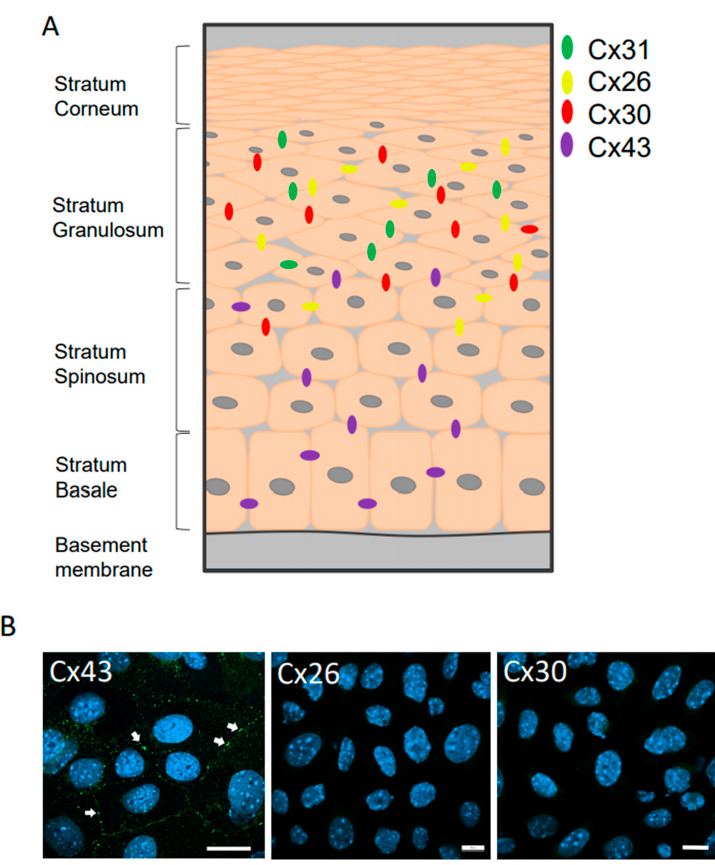
Figure 1. ( A ) Schematic model denoting the approximate location of Cx26, Cx30, Cx31 and Cx43 expression in rodent epidermis. Note that Cx43 is found primarily in the basale and spinosum